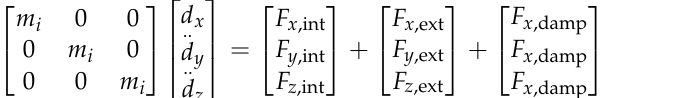
Figure 7. The ε − σ relationship of cables in this study (OA: Elastic stage; AB: Yielding stage). The dynamic response of structures is actually a function of time and space. The motion response of mass particles can be regarded as a series of sequential motions in small time steps [32]. The motion of mass particles in a small time step is called a path unit, which can be calculated based on Newton’s second law [33]. For the mass particle i , the expression can be expressed as